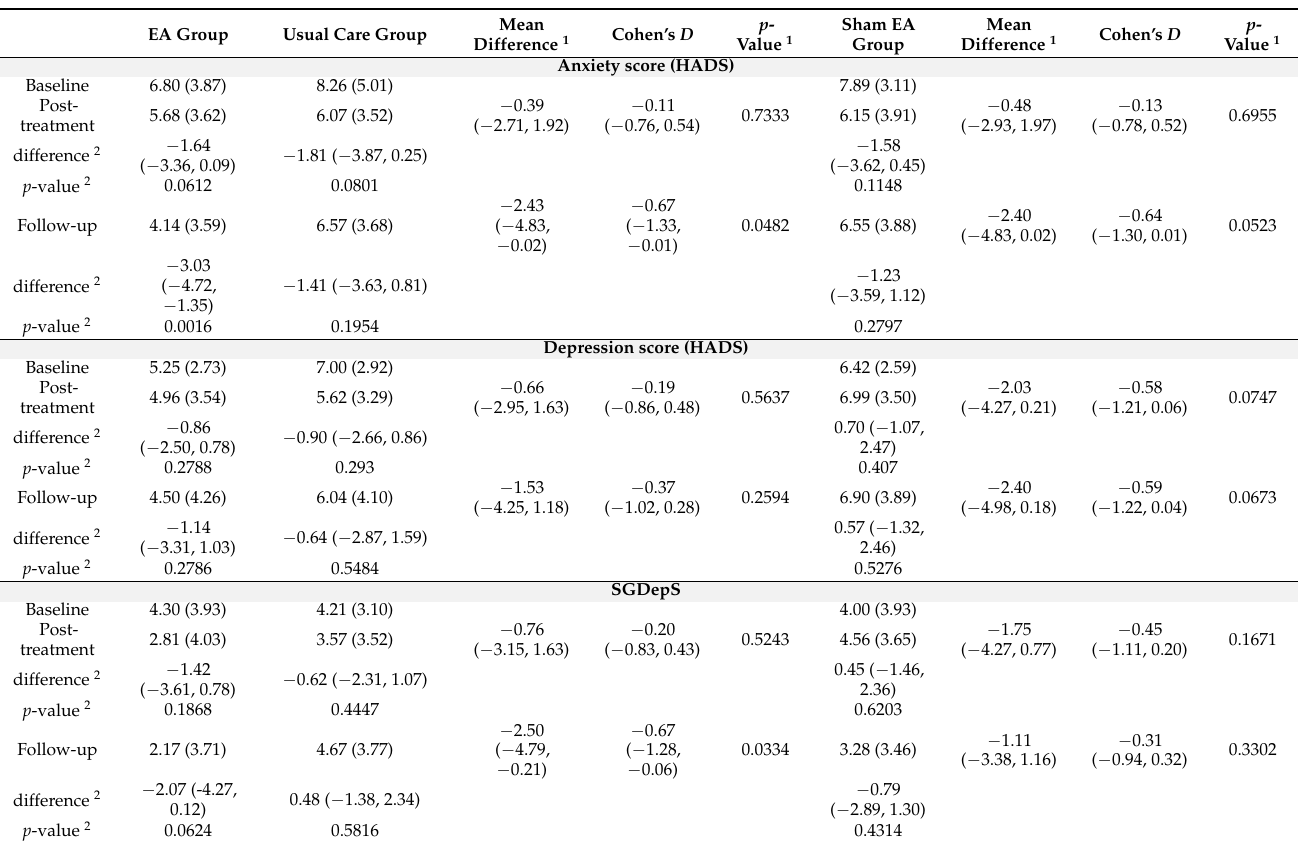
Table 4. Effects of 12-week EA Treatment on HADS and SGDepS.